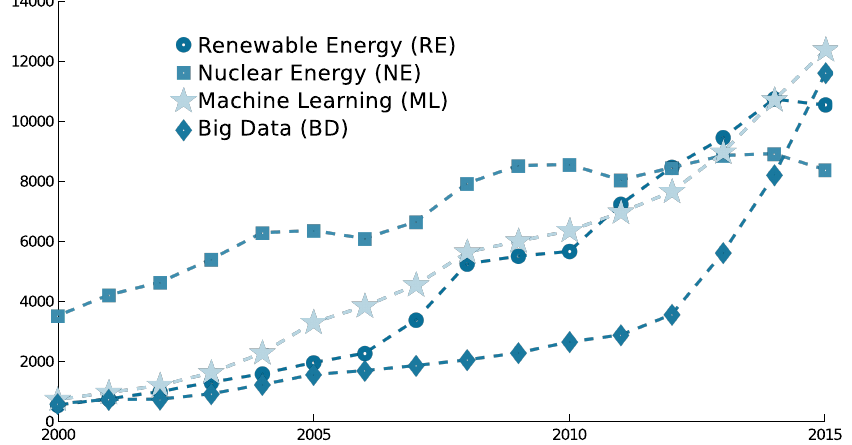
Figure 1. Publication trends for different areas of research. Each point in the figure represents the number of research publications per year that include the term in the article title, abstract or keywords (source: Scopus).